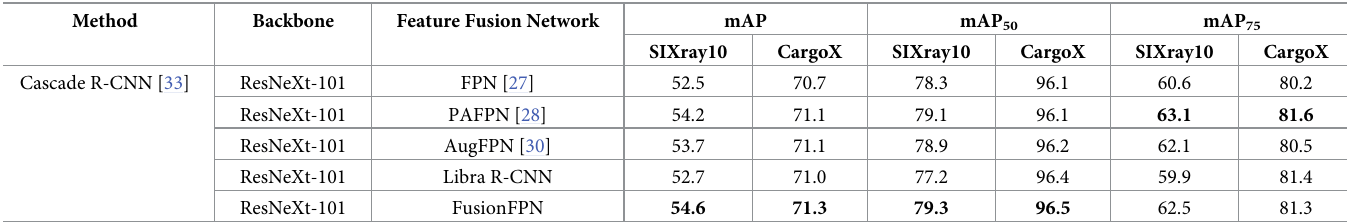
Table 3. Comparison of the performance of the fusion feature pyramid network with state-of-the-art feature fusion networks on the CargoX dataset. Method Backbone